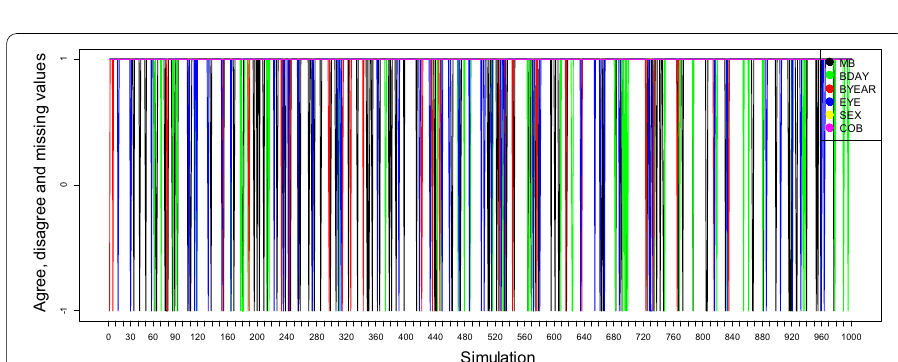
Fig. 5 Agreement values (agree, 1; disagree,